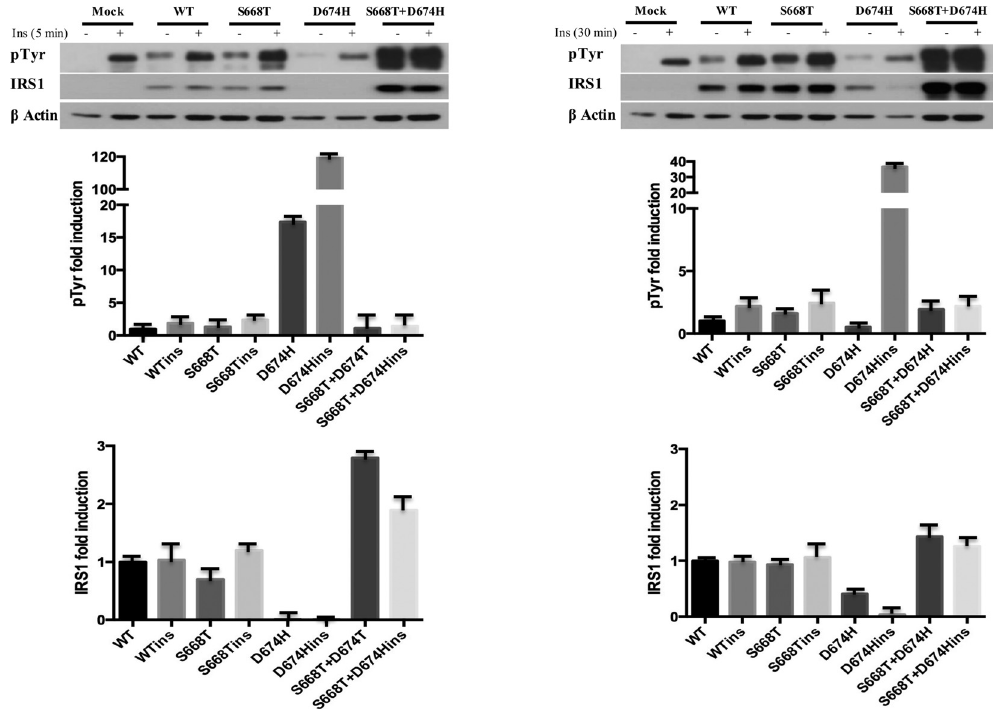
Figure 1 - Insulin-induced tyrosine phosphorylation and expression level of IRS1 is altered by S668T and D674H mutants in 293T cells. One hundred (cid:4) g of total protein was fractionated by 10% SDS-PAGE. Blots were first labeled with anti-phospho-specific antibodies, stripped and reprobed with non-phospho-specific antibody. Fold induction of phosphorylation was determined by dividing densitometric values of the phospho- band by that of total protein bands. Relative abundance of IRS1 was determined by dividing the densitometric values of IRS1 to that of beta-actin.